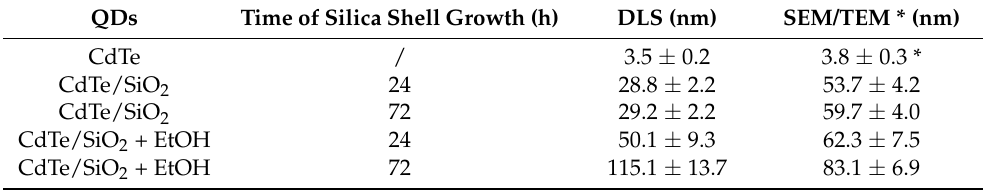
Table 1. Quantum dots (QDs) average hydrodynamic particle diameter (nm) obtained by Dynamic Light Scattering (DLS), and average particle diameter (nm) obtained by Scanning Electron Microscopy (SEM) and Transmission Electron Microscopy (TEM) measurements. Result obtained by TEM is marked by *.